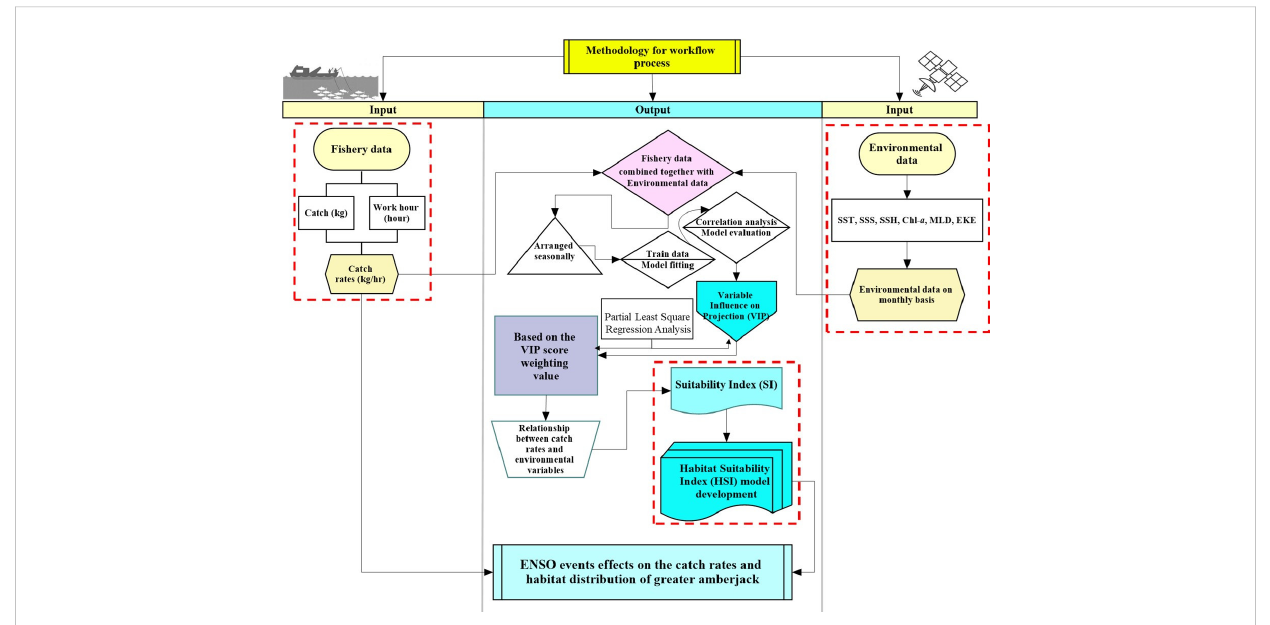
FIGURE 1 Methodological framework for data interpretation and